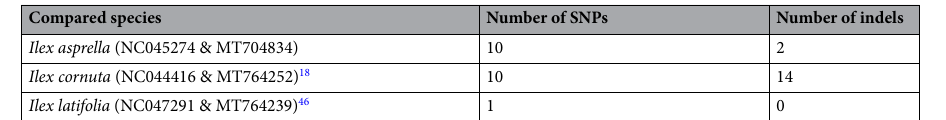
Table 3. Intraspecific comparison of the single-nucleotide polymorphisms (SNPs) and indels of Hong Kong Ilex and reference genomes.